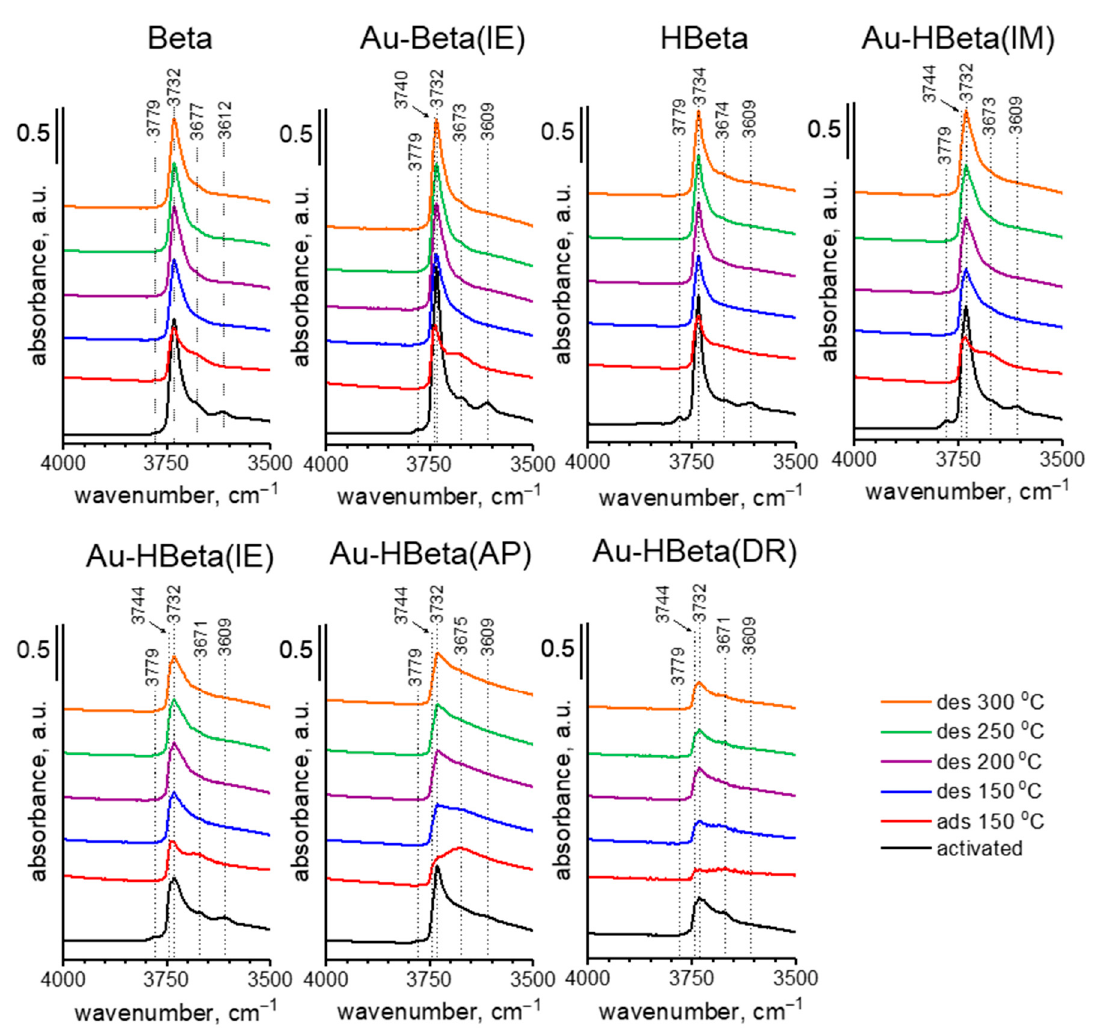
Figure 6. Hydroxyl groups vibration range of FTIR spectra recorded after activation at 350 °C, adsorption (at 150 °C), and desorption of pyridine (at 150, 200, 250, and 300 °C). All the spectra were normalized to the density of a wafer of 10 mg·cm − 2 .